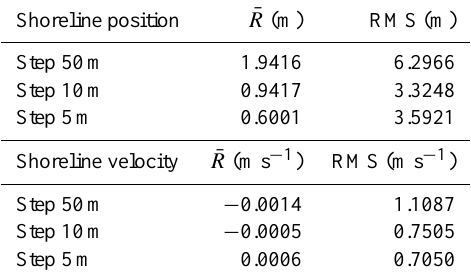
Table 1. Benchmark 1: mean ( ¯ R ) and root mean square (RMS) of − θ C the residuals θ T for shoreline position and velocity calculated i i over 400s simulation time. The residuals are plotted in Fig. 6.